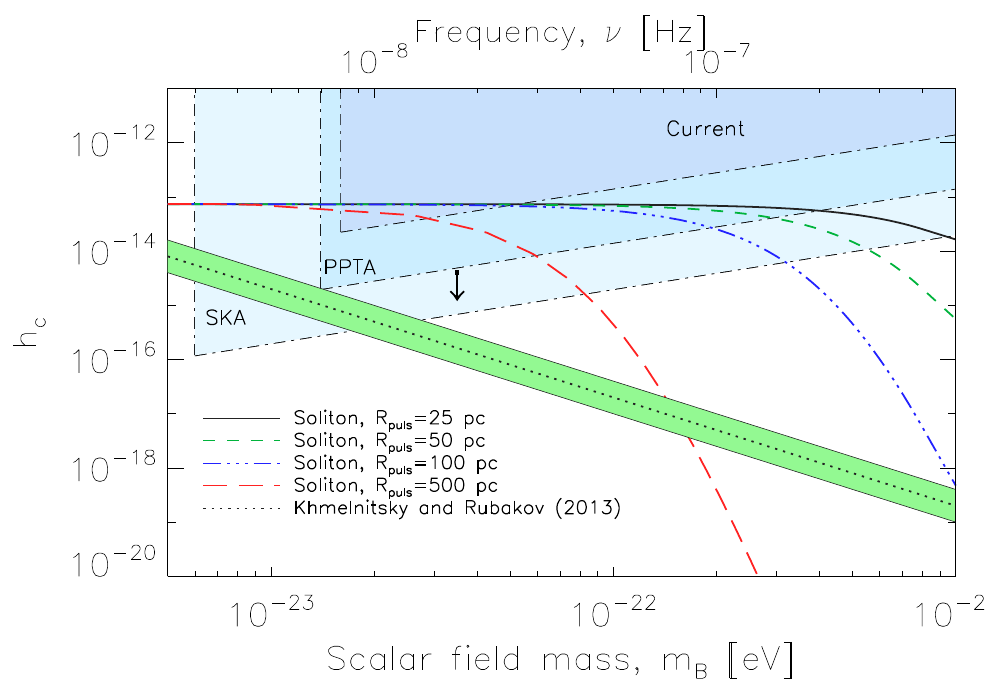
Figure 2. The characteristic strain measured between pairs of pulsars is shown. It is compared with the expected sensitivities from the current and forthcoming PTA experiments (adapted from